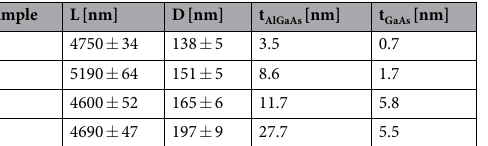
Table 1. Characteristic geometric parameters for the four samples together with their standard deviations. The four samples exhibit low fabrication error